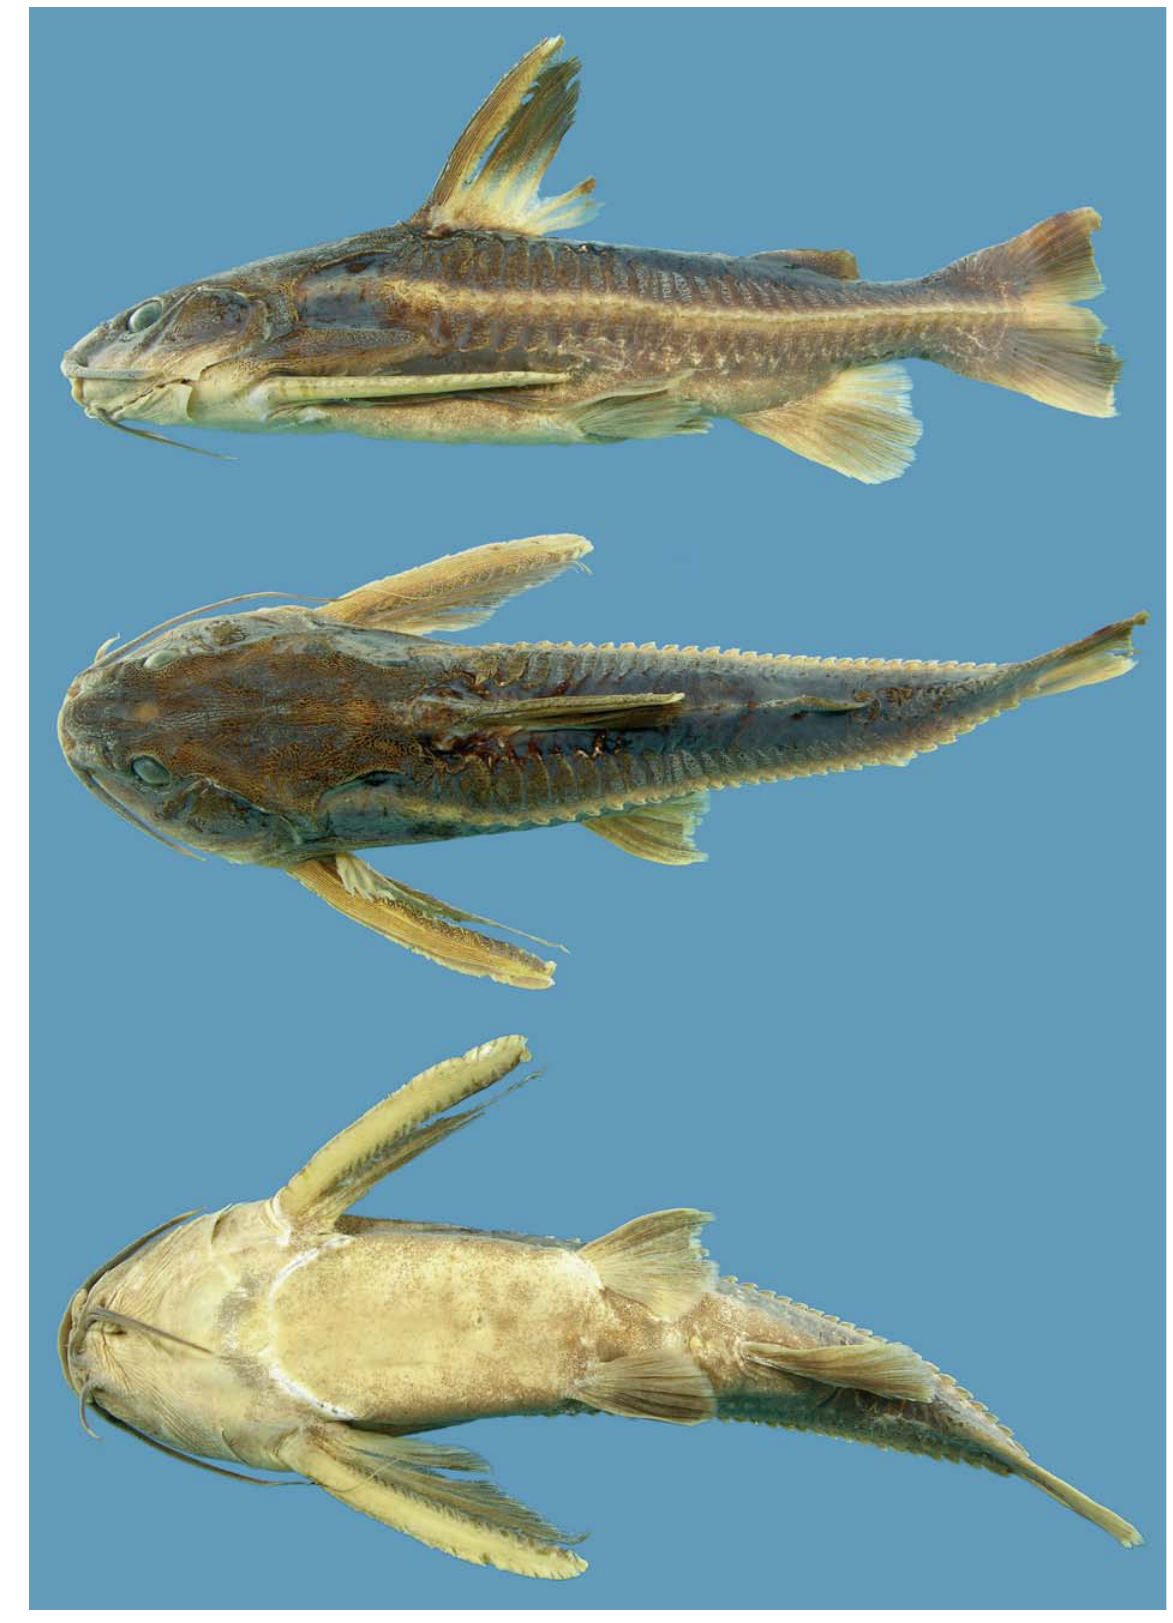
Fig. 3. Holotype of Platydoras brachylecis , MZUSP 43593, 137.7 mm SL, Brazil: Maranhão: lago dos Viana, Pindaré-Mearim river system, 03º13’S 45º10’W, B. V. O. Moura, April 1984. Photos by M. Arce